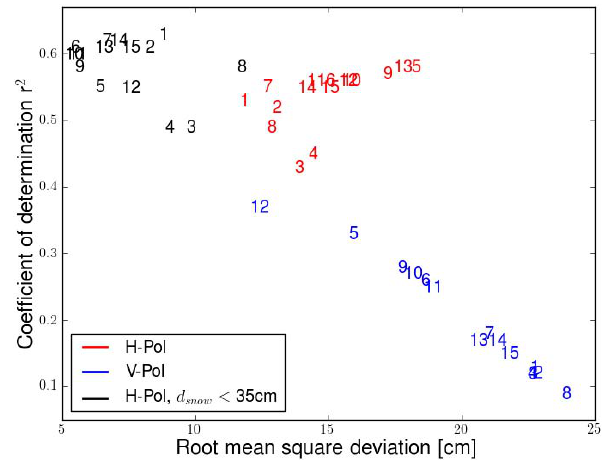
Fig. 8. Coefficients of determination r 2 and root mean square devi- ations for the IceBridge snow thicknesses and the snow thicknesses retrieved from SMOS brightness temperatures for 15 different sim- ulation scenarios. The numbers give the scenario number. The red and blue numbers show the results for the consideration of all snow thicknesses. The red numbers indicate horizontal, the blue numbers vertical polarisation. The black numbers indicate the results for hor- izontal polarisation, when only snow thicknesses d snow < 35cm (as retrieved from SMOS) are